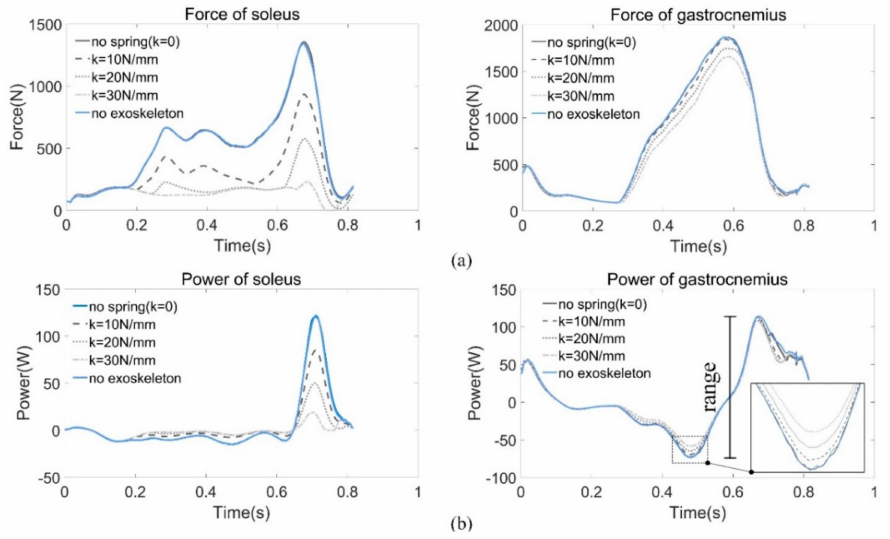
Figure 11. ( a ) Forces of soleus and gastrocnemius under di ff erent sti ff ness conditions. ( b ) Power comparison during the stance